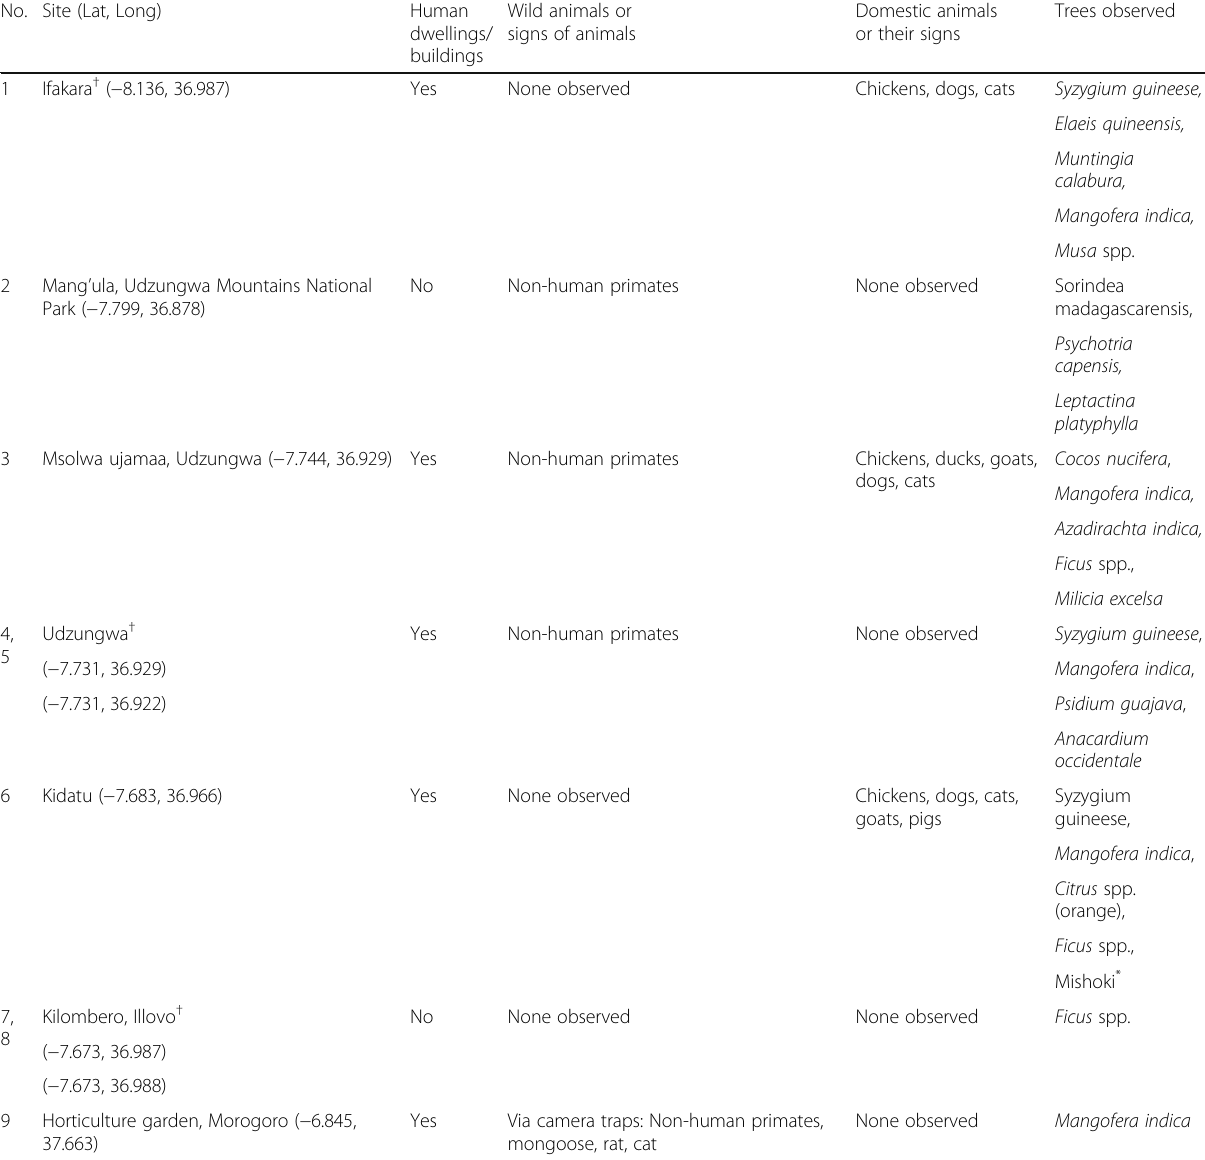
Table 3 Characteristics of nine sites frequented by Eidolon helvum No. Site (Lat, Long) Human